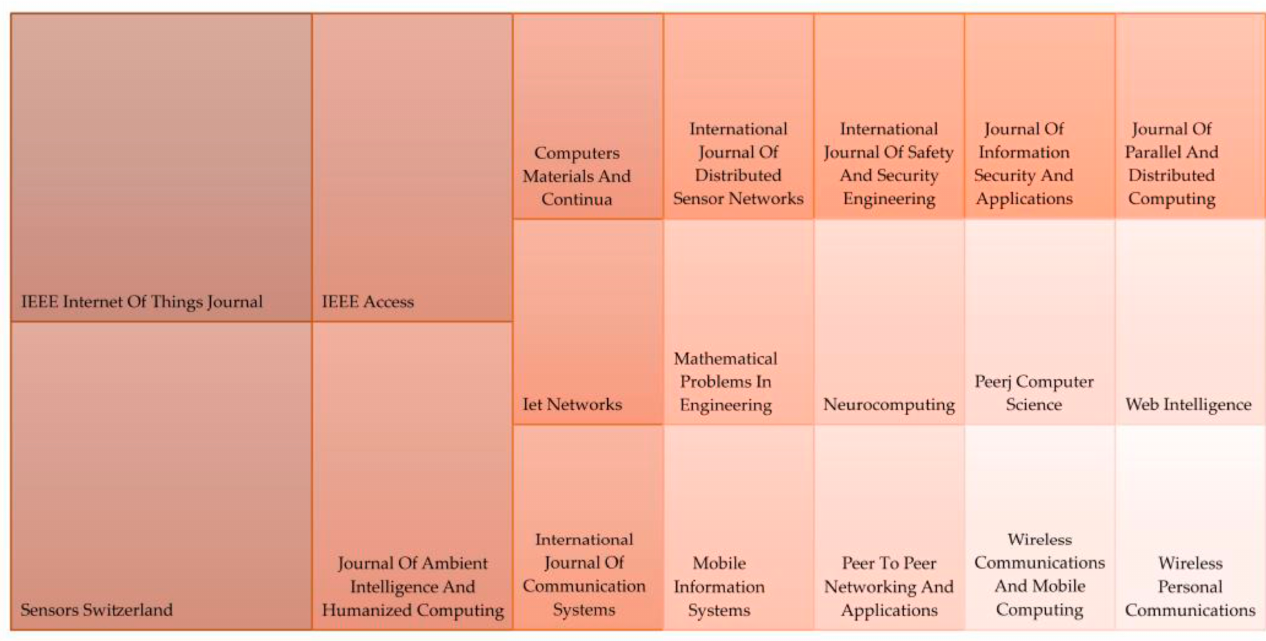
Figure 5. Research distribution according to Journals.